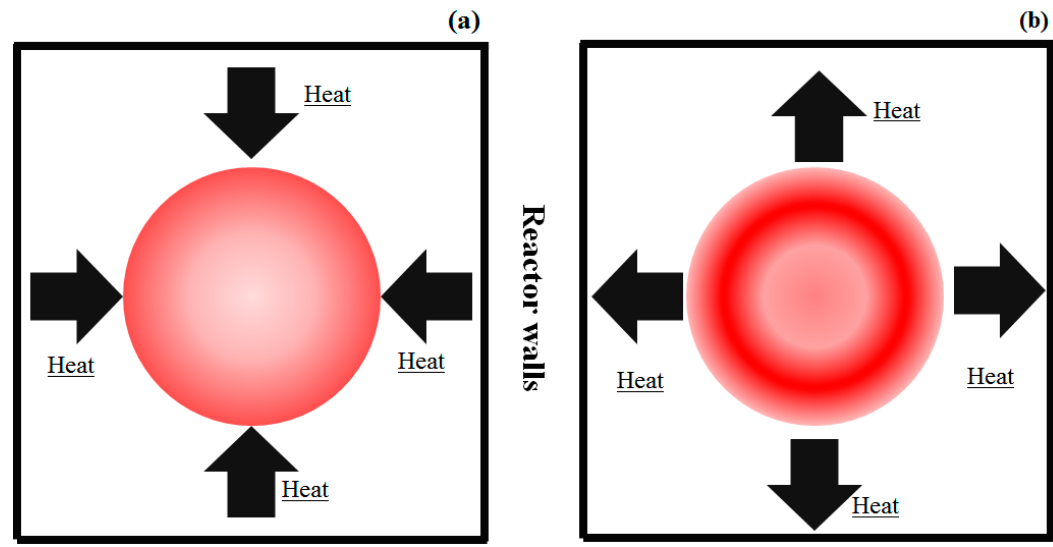
Figure 1. Heat dissipation of same material using ( a ) traditional heating process and ( b ) under microwave (MW) field. Deep colour intensity represents higher temperature regions inside the material.